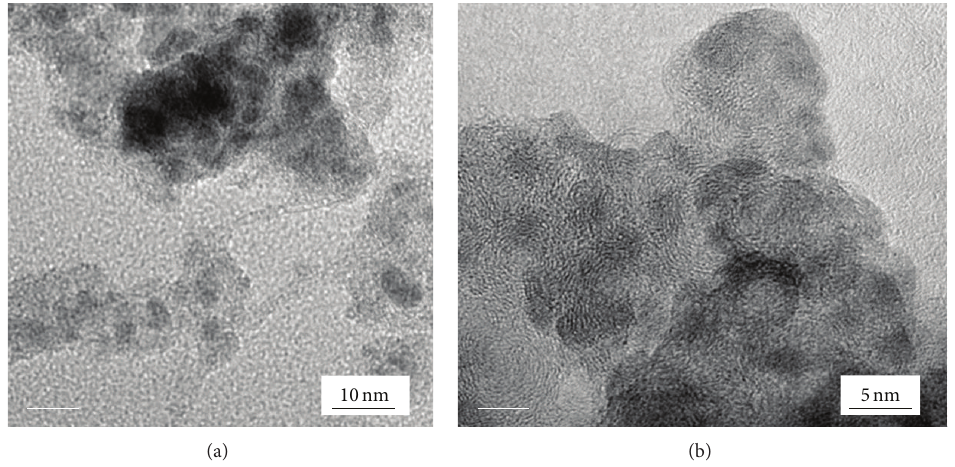
Figure 2: The typical TEM images of the film grown on the FTO; (a) and (b) are the low magnification image and high magnification image of the composite film, respectively.